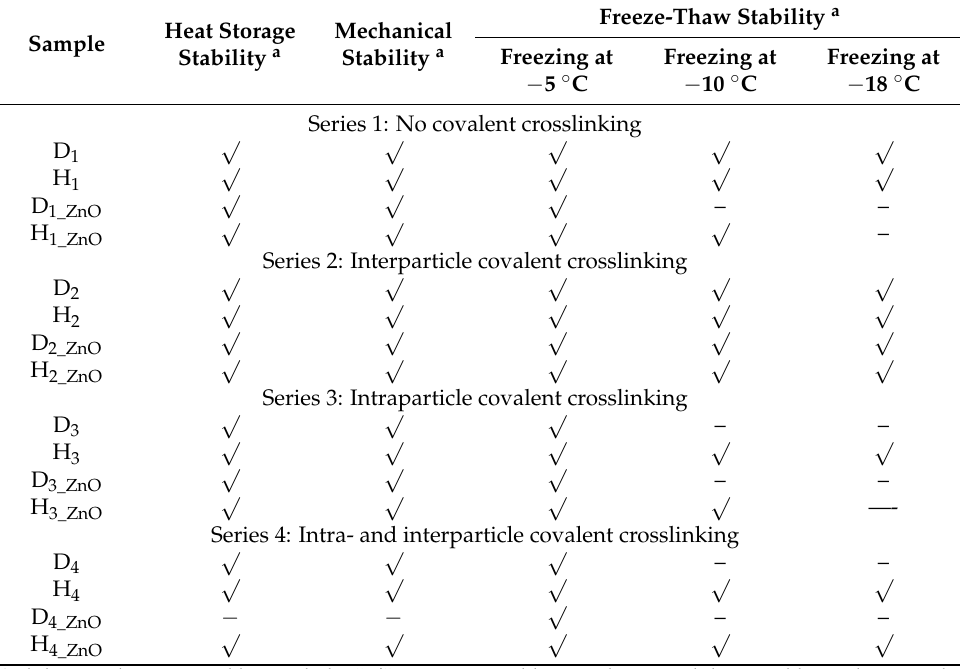
Table 5. Stability testing results of latexes, differing in the covalent crosslinking strategy, surfactant type and the application of nanostructured ZnO